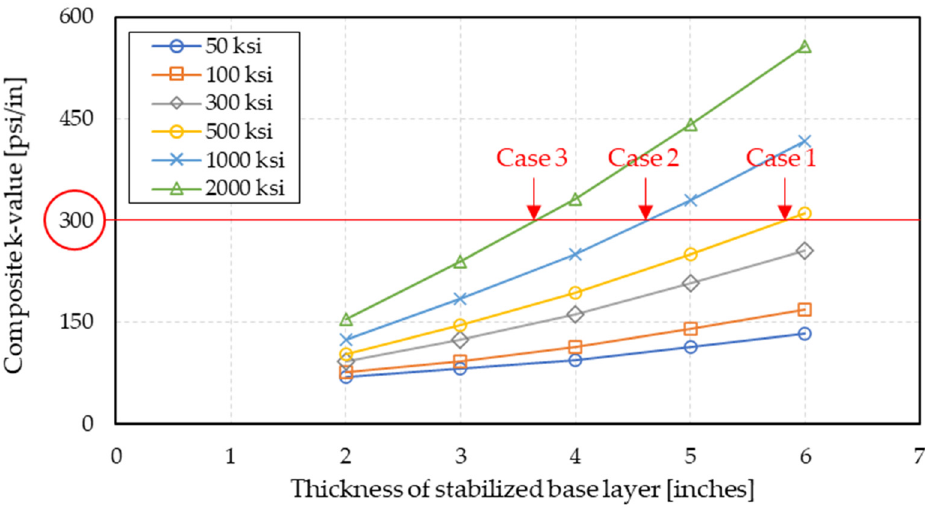
Figure 5. Example of selecting compositions for a desired composite k -value of 300 psi/in (effect of elastic modulus of the stabilized base material on the composite k -value when k e = 50 psi/in) (1 ksi = 6.89 MPa, 1 psi/in = 271 kN/m 3 ).